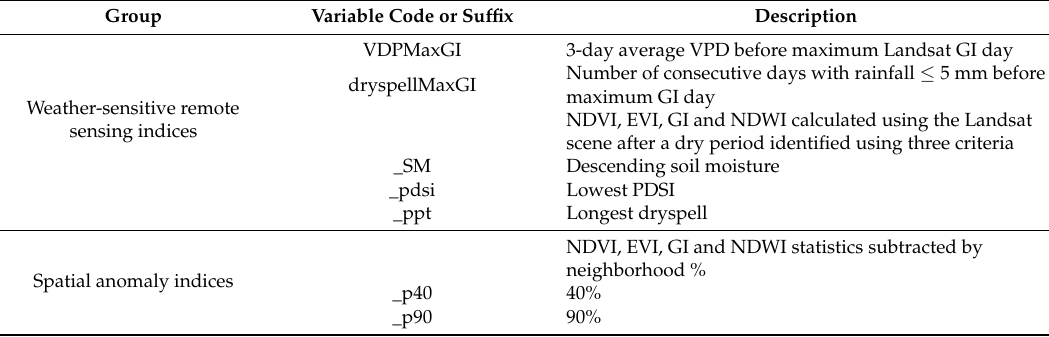
Table 2. Weather-sensitive remote sensing, spatial anomaly and composite